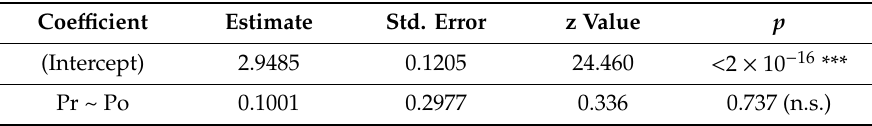
Table A1. Analysis of adpositional